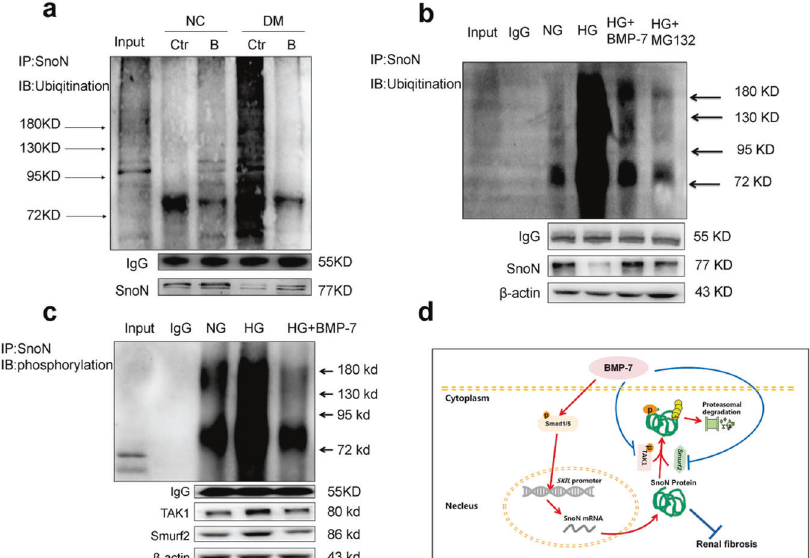
Fig. 8 BMP-7 modulates ubiquitination of SnoN in renal tubular cells during DN. Immunoprecipitation shows the phosphorylation and ubiquitination of SnoN in the kidney tissues and NRK-52E cells in different groups. a Input:whole renal tissue lysis from NC group NC + Ctr: vehicle injection in normal mice;NC + B:OE-BMP-7 plasmid injection in normal mice;DM + Ctr:vehicle injection in diabetic mice;DM + B:OE- BMP-7 plasmid injection in diabetic mice. b Input:whole protein lysis from the NRK-52E cells;IgG:the negative control group of IP was treated with IgG antibody;NG:normal-glucose control group;HG:high-glucose control group;HG + BMP-7:high glucose + BMP-7(200 ng/mL rhBMP-7); HG + MG132:high glucose + MG132(5 μ mol/L). c Input:whole protein lysis from the NRK-52E cells;IgG:the negative control group of IP was treated with IgG antibody;NG:normal-glucose control group;HG:high-glucose control group;HG + BMP-7:high glucose + BMP-7(200 ng/mL rhBMP-7). d Schematic image of the molecular mechanisms involved in the role of BMP-7 in restoring SnoN protein level.BMP-7 upregulates SnoN mRNA and protein levels by activating the classical Smad1/5 pathway to refrain from the partial EMT of RTECs and the deposition of ECM in DKD-induced renal fi